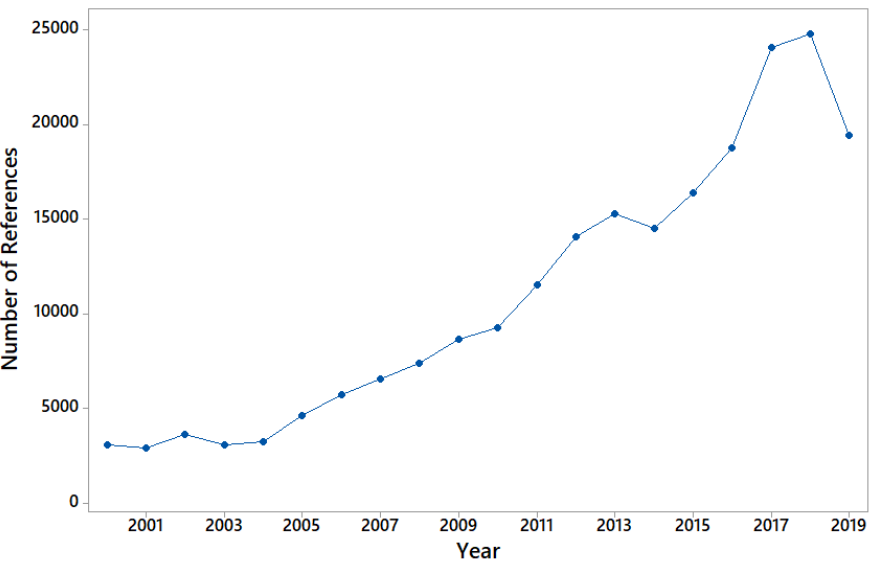
Figure 3. Time evolution of Metaheuristics and Simulation references in Business and Management in the Web of